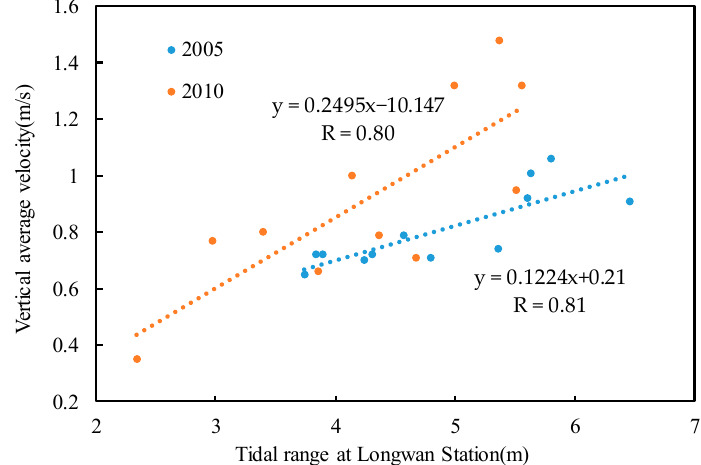
Figure 13. Correlation between tidal range and vertical average velocity at Longwan station.